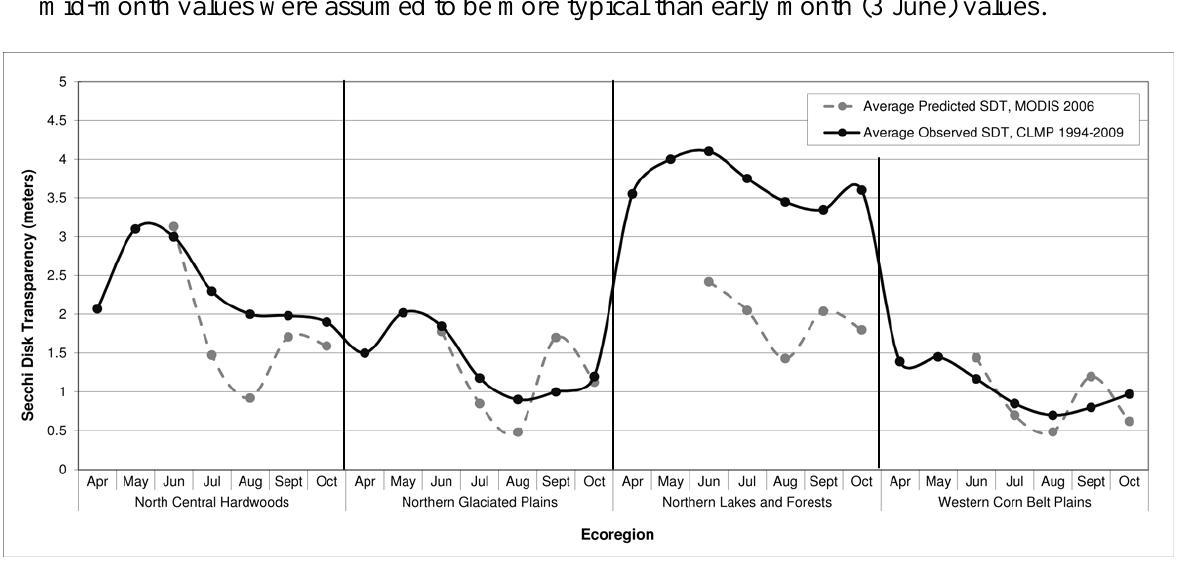
Figure 5. Summer water clarity patterns, as predicted by MODIS imagery and observed by in-situ SDT data collected over a 25-year span. Higher Secchi depths correspond to higher water clarity. Note: 19 June MODIS predicted values were used for the “June” entry because mid-month values were assumed to be more typical than early month (3 June)